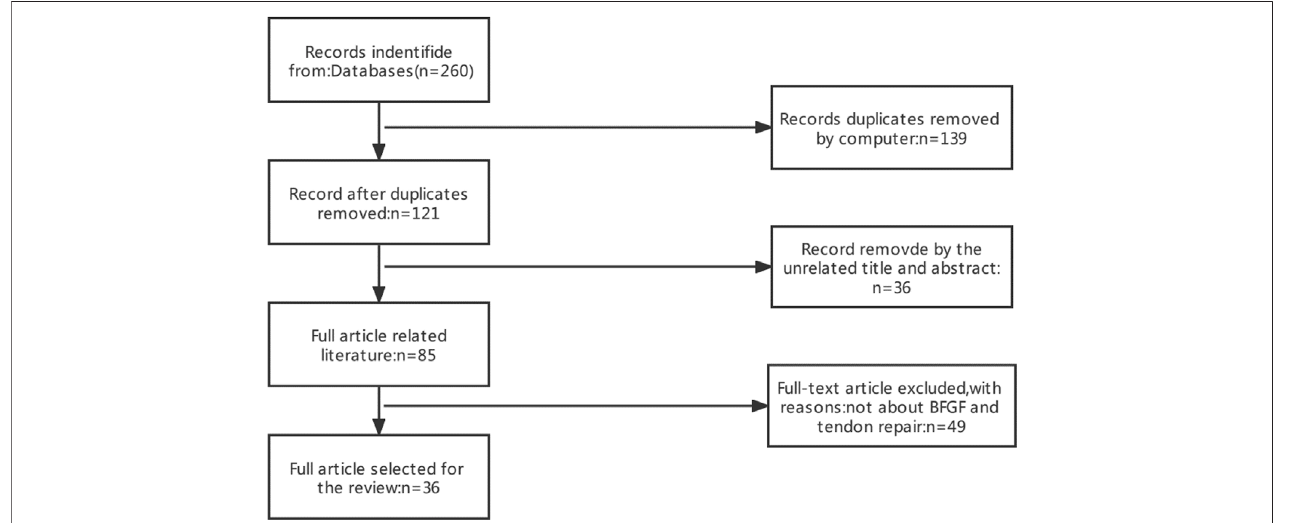
FIGURE 1 | Article Retrieval Flow Chart with inclusion and exclusion